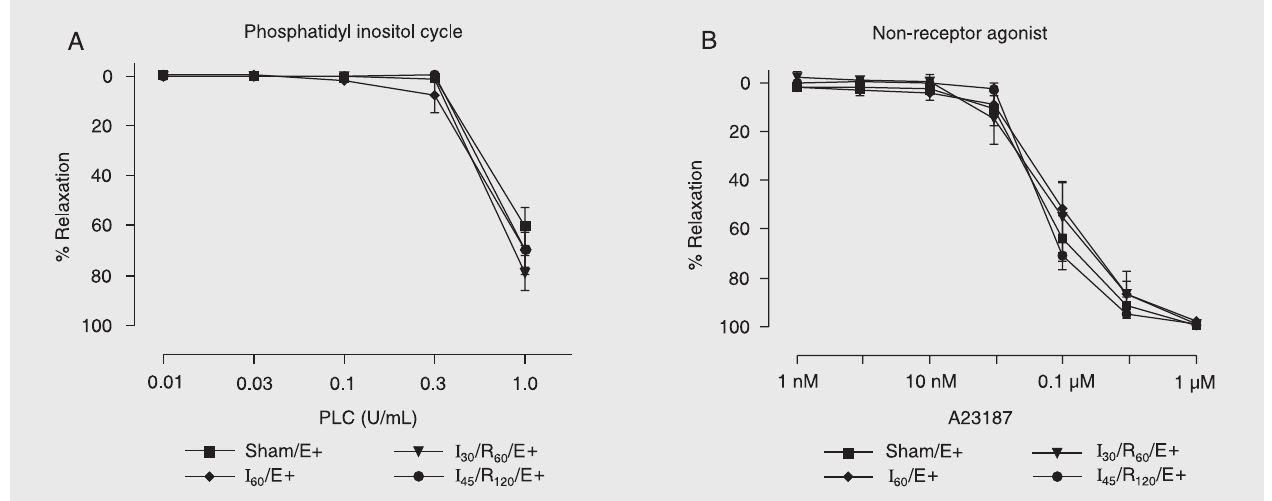
3. Concentration-response curves to phospholipase C (PLC, A) and calcium ionophore A23187 (B) by hepatic artery endothelial cells. Hepatic artery segments were exposed to sham operation (Sham), 60 min of ischemia (I 60 ), 30 min of ischemia followed by 60 min of reperfusion (I 30 /R 60 ), and 45 min of ischemia followed by 120 min of reperfusion (I 45 /R 120 ) with endothelium (E+). Data are reported as means ± SEM, N = 6 per group. Arterial segments were first contracted with prostaglandin F 2 α and exposed to increasing drug concentrations. No significant difference was found among groups